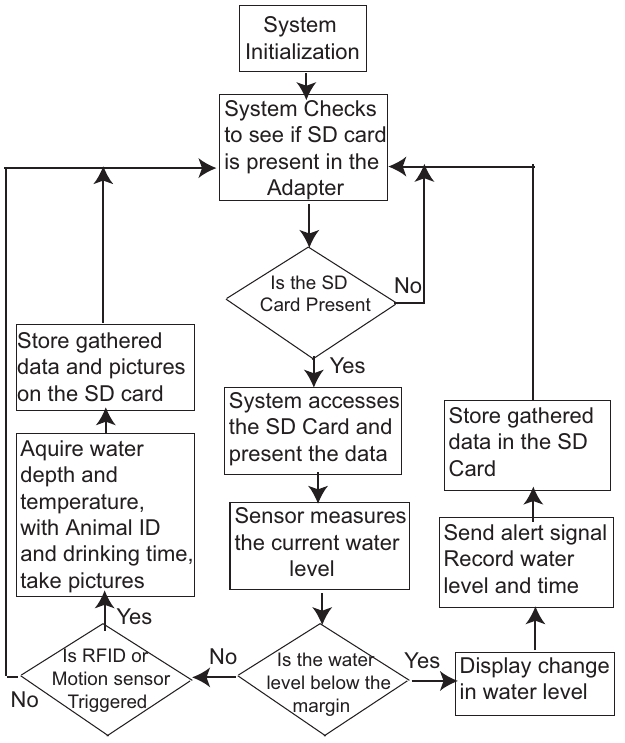
Figure 3. The flow chart of the control program for sensing, processing, and data